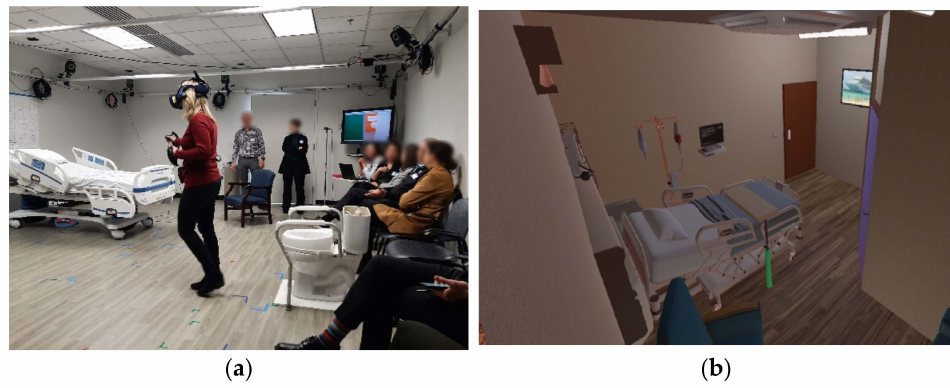
Figure 4. AR activities. ( a ) One AC member completes tasks while others observe them both directly and indirectly (seeing AR participant’s view on a large screen); ( b ) sample view of AR